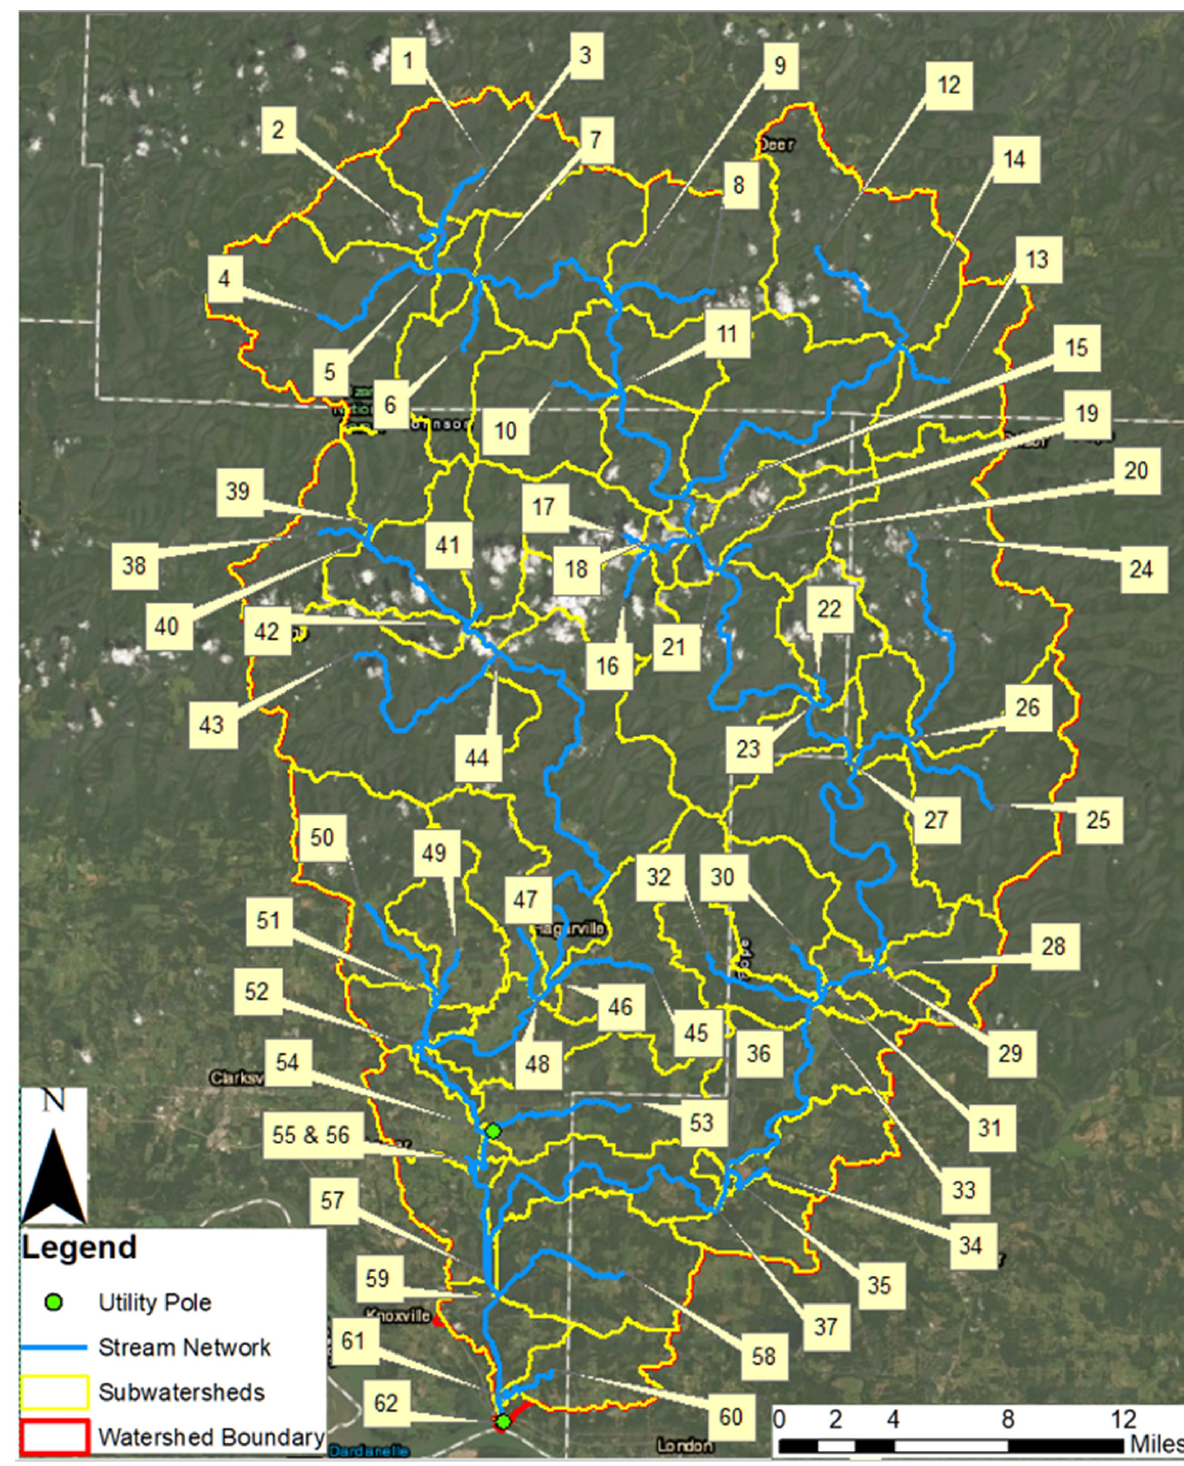
Figure 3. London, Arkansas watershed with labeled nodes shown in yellow square text boxes (35.345107 ◦ , − 93.329761 ◦